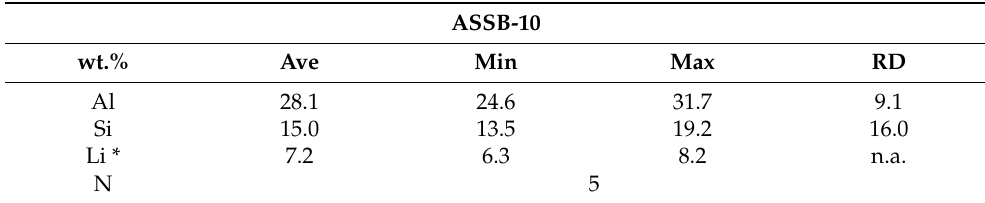
Table A5. Composition of Li 2 Al 2 SiO 6 (wt.%) based on single-point analysis (only in ASSB-10). Ave.: arithmetic average; Min./Max.: lowest/highest measured values; RD: relative standard deviation (%); * calculated value; N: number of measurements; n.a. not applicable (calculated values).